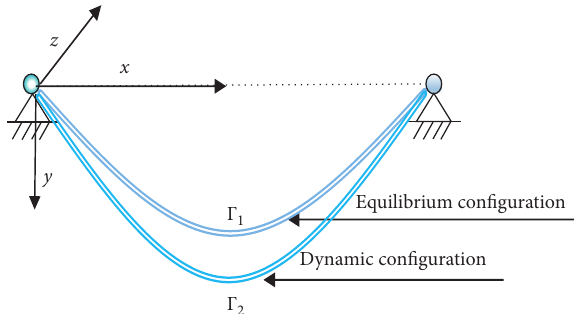
Figure 1: The mathematical model of the